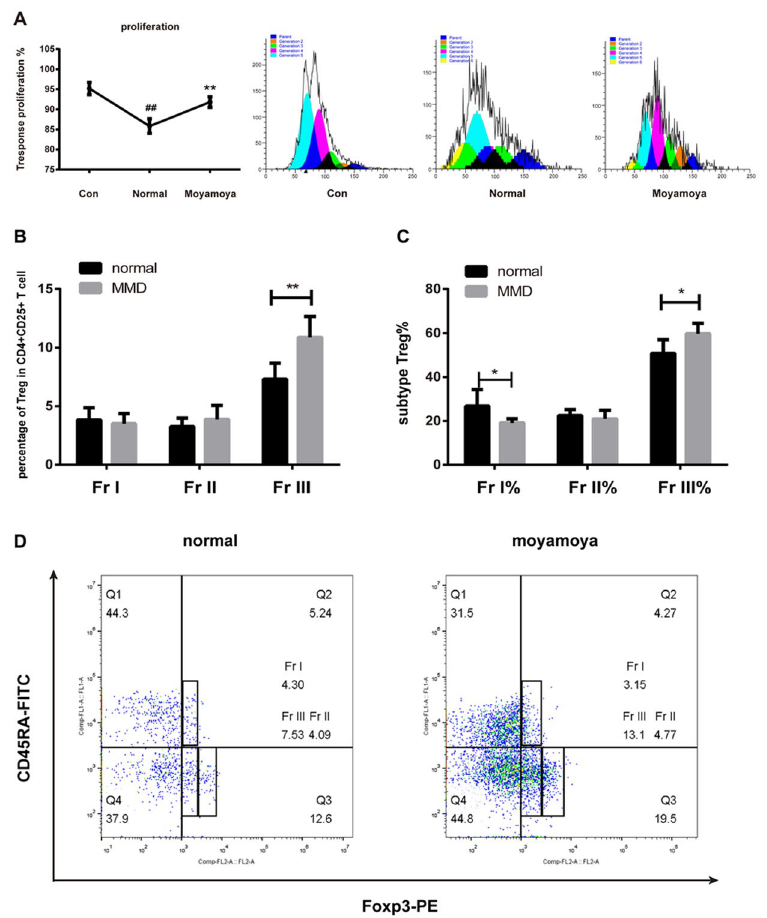
Figure 2. The proliferation of CD4 + CD25 − T cells co-cultured with Treg ( A ). The suppressive function of Treg isolated from MMD patients was lower than controls. The changes of Treg subtypes in MMD patients and healthy controls. Both the percentage of FrIII Treg cells among CD4 + CD25 + T cells ( B ) and total Treg cells ( C ) were significantly elevated in MMD patients. FACS plots for subtypes of Treg cells in MMD patients and healthy controls ( D ). Each bar represents the mean ± SD of three independent experiments. * P < 0.05 and ** P < 0.01 vs. normal Treg cells group, ## P < 0.01 vs. control group.